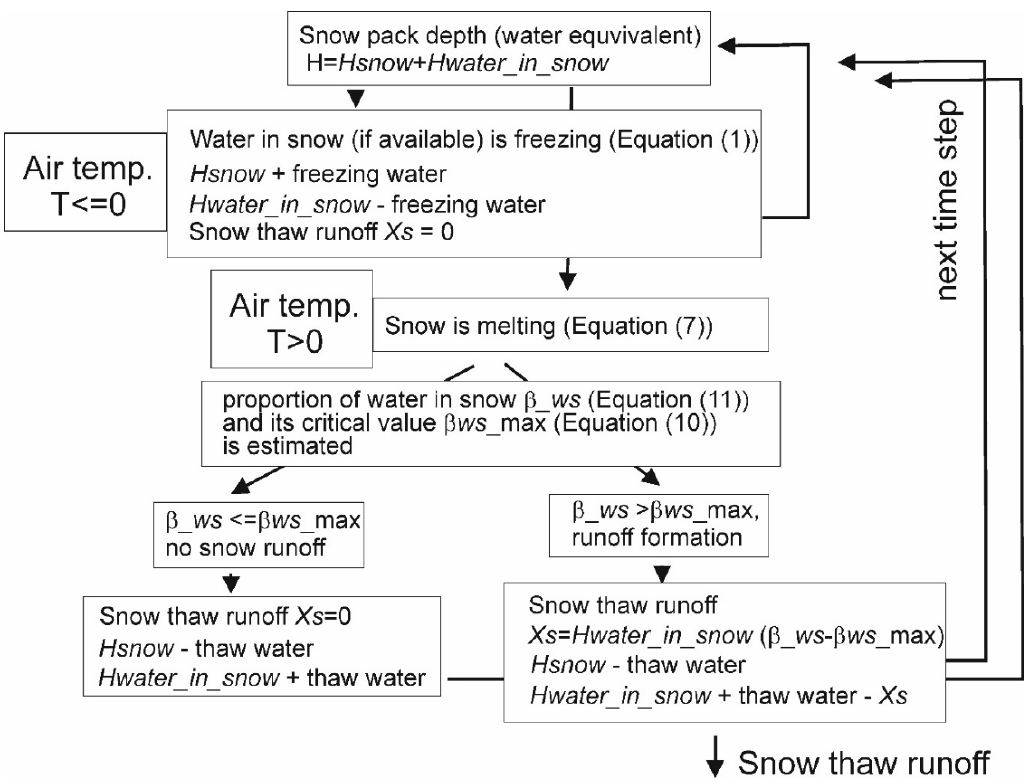
Figure 5. The block-diagram of the surface runoff calculation with the melt coefficient approach. The initial snow pack depth H = Hs has irregular pattern on the catchment. Snow is driven by The Period of Summer wind during the winter and accumulates in depressions (river and gully valleys), near steep slopes, and in dense vegetation. The measurements on the gullied territory of the west-central Yamal peninsula [8] showed the typical distribution of snow depth/mean snow depth ratio ( Nratio ) at the